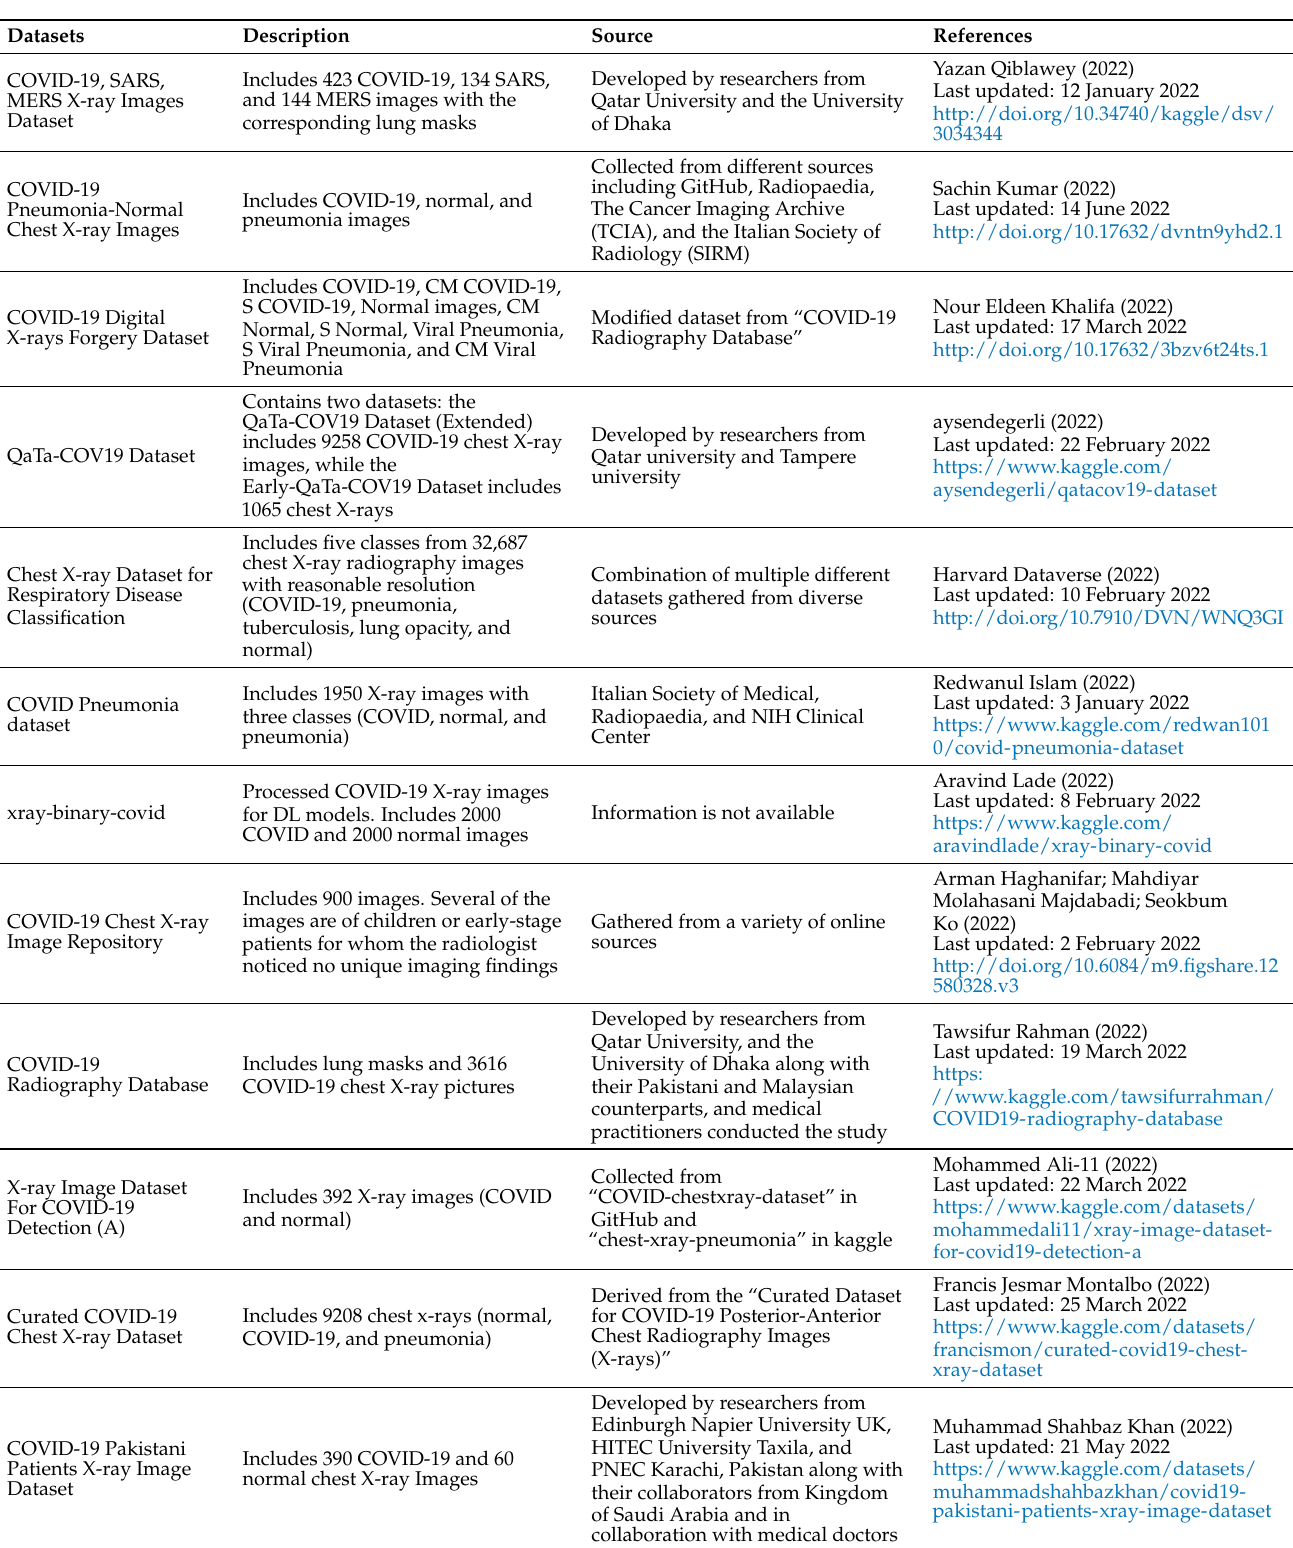
Table 1. COVID-19 X-ray Image